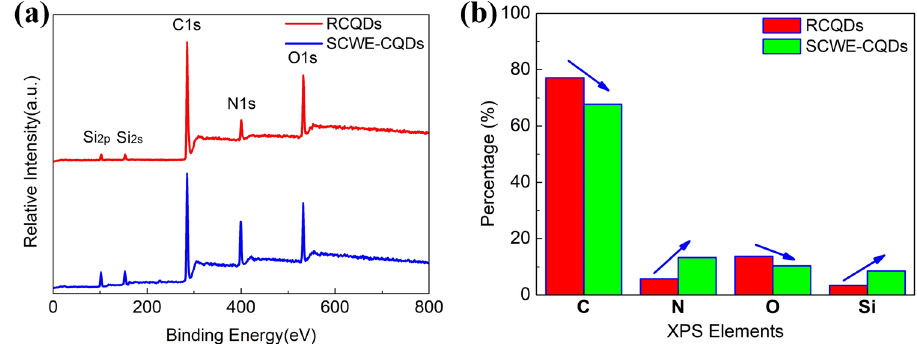
Figure 6: ( a ) XPS full survey of RCQDs and SCWE - CQDs, ( b ) XPS elemental analysis results of the RCQDs and SCWE -